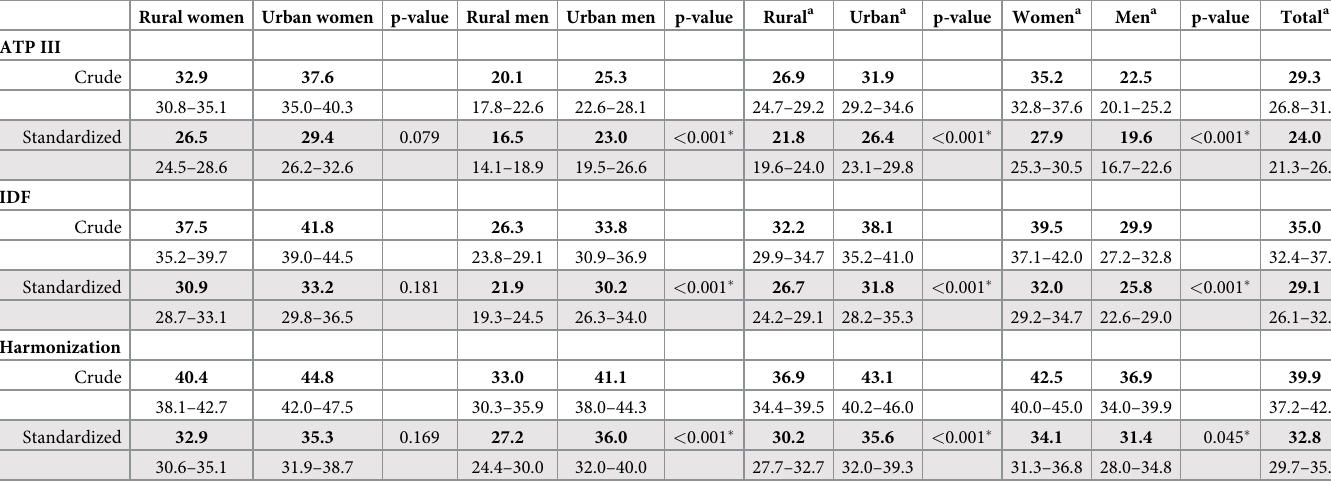
Table 3. Crude and age standardized prevalence of metabolic syndrome using ATP III, IDF and Harmonization